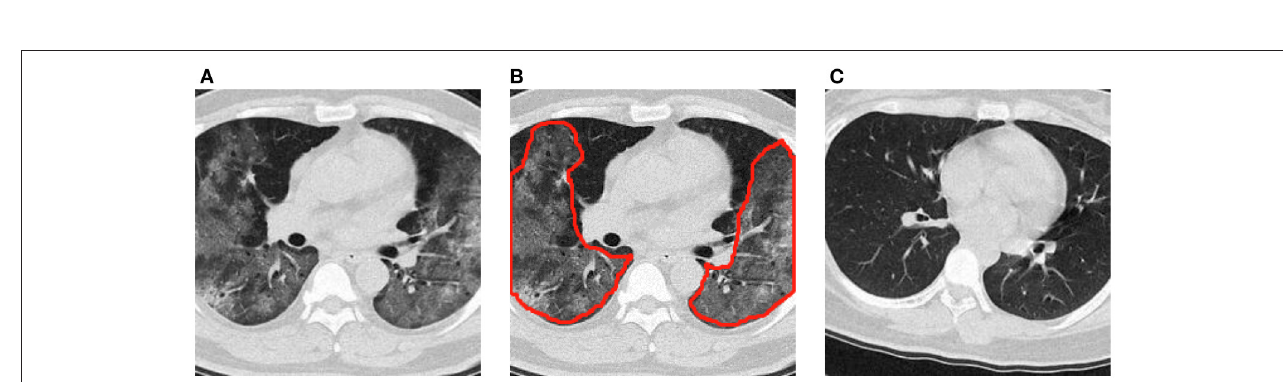
FIGURE 4 | Samples of preprocessed images in our dataset. (A) COVID-19. (B) Lesions in (A) . (C) HC.